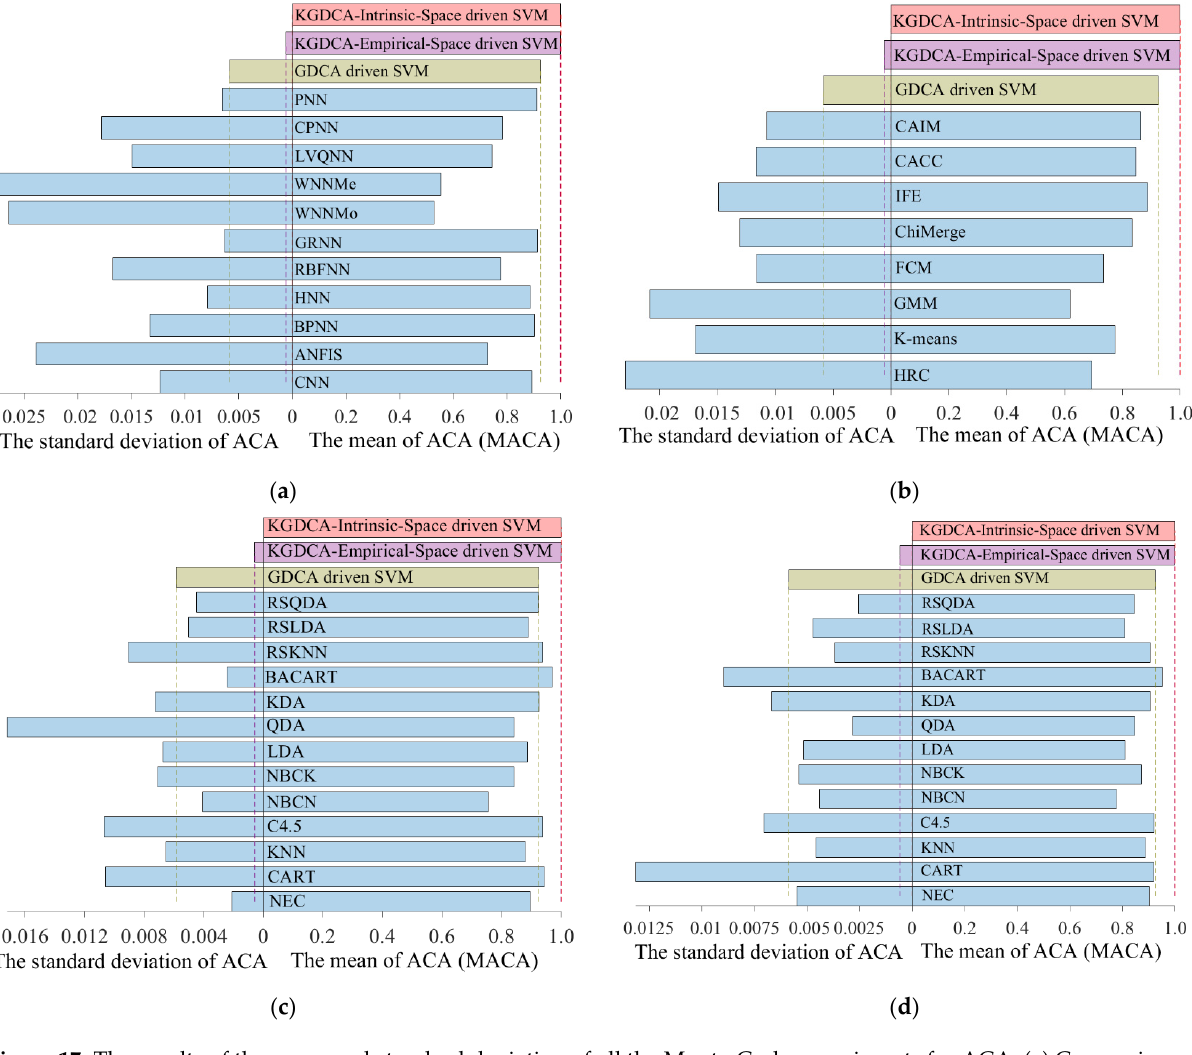
Figure 17. The results of the mean and standard deviation of all the Monte-Carlo experiments for ACA. ( a ) Comparisons with ten kinds of neural networks. ( b ) Comparisons with classical rough set. ( c ) Comparisons with the remaining recognition methods without attribute reduction of NRS. ( d ) Comparisons with the remaining recognition methods with attribute reduction of NRS.